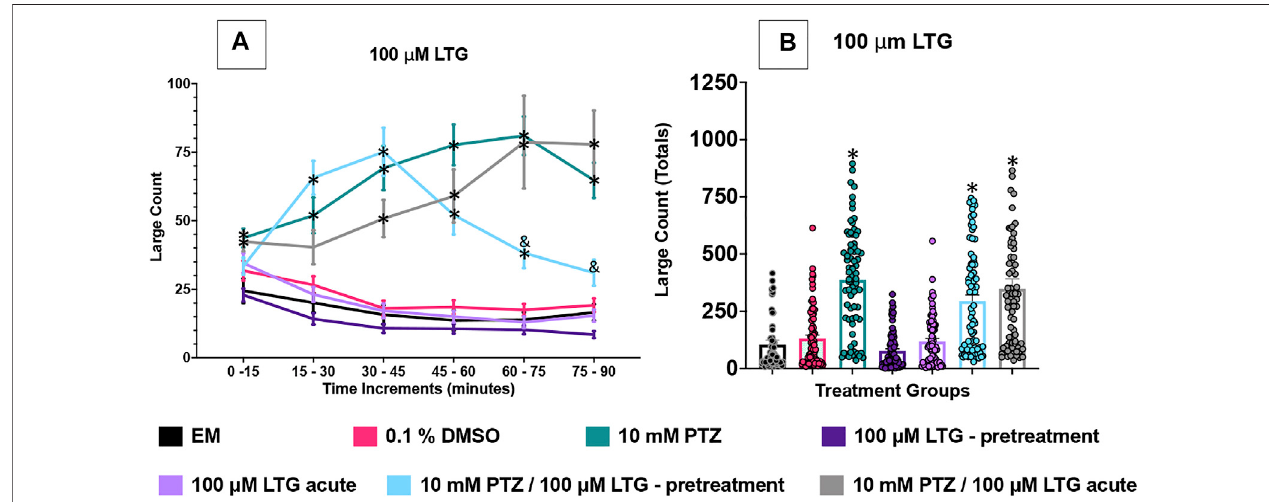
FIGURE 3 | Behavioral pro fi le of zebra fi sh larvae exposed to lamotrigine. (A) The average large count ( y -axis) of larvae is depicted per 15 min interval ( x -axis) of the tracking session. The respective treatment groups are listed on the x -axis. Analyses (two-way ANOVA, Tukey ’ s post-hoc) are marked * ( p < 0.05) to indicate signi fi cant differencestoembryomedium(EM).Standarderrorofthemeansisshown.Analyses(two-wayANOVA,Tukey ’ spost-hoc)aremarked&( p < 0.05)toindicatesigni fi cant differencesto10 mMPTZ. (B) Thetotallargecount( y -axis)over90 minisdisplayed.Therespectivetreatmentgroups( x -axis).Analyses(one-wayANOVA,Tukey ’ s post-hoc) aremarked* ( p < 0.05) toindicate signi fi cantdifferences toembryo medium (EM).Standarderror ofthemeans isshown. Analyses(one-way ANOVA, Tukey ’ s post-hoc) are marked & ( p < 0.05) to indicate signi fi cant differences to 10 mM PTZ. ( n = 76 fi sh/treatment group).